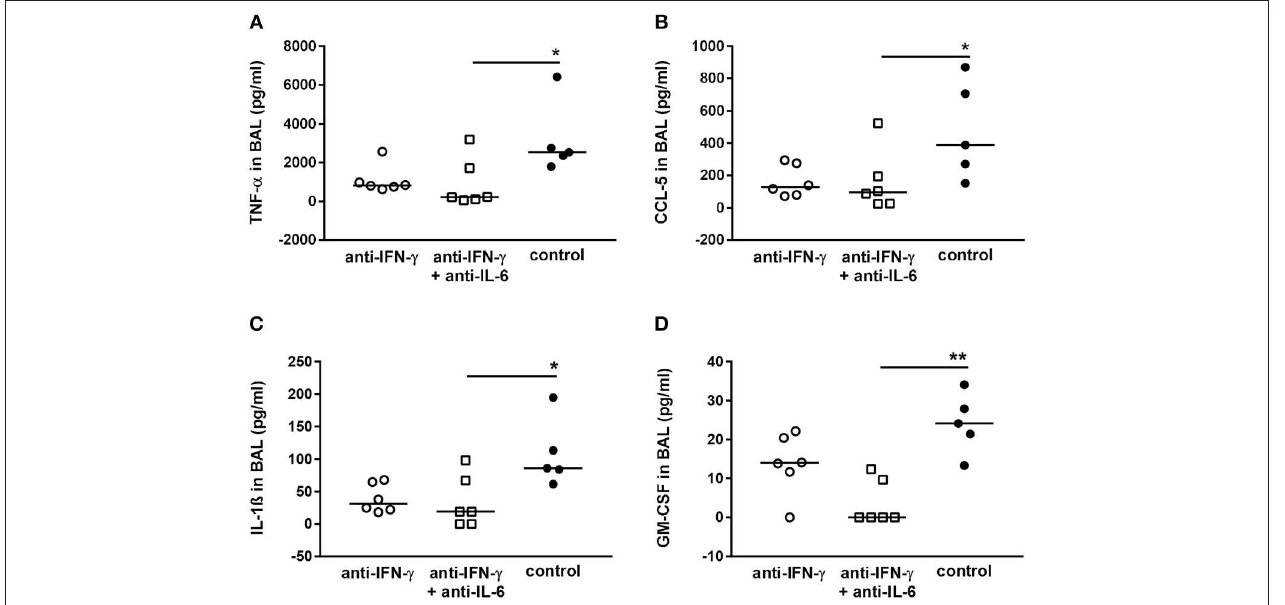
FIGURE 7 | Double-neutralization of IFN- γ and IL-6 during co-infection with 0.17 TCID 50 IAV and 1 × 10 6 CFU S. pn. significantly affects TNF- α , CCL-5, Il-1ß, and GM-CSF protein levels in BAL. Mice were infected intranasally (i.n.) with 0.17 TCID 50 IAV on day 0. On day 5, mice were intraperitoneally (i.p.) injected with anti-IFN- γ antibody alone or in combination with anti-Il-6 antibody. On day 7, mice were treated with anti-IFN- γ antibody alone or in combination with anti-IL-6 antibody oropharyngeally (o.p.) and at the same time infected with 1 × 10 6 CFU S. pn. o.p. The control group was treated with an isotype IgG antibody and infected likewise. (A–D) Protein levels of TNF- α , CCL-5, Il-1ß, and GM-CSF in bronchoalveolar lavage (BAL) 24h post o.p. antibody treatment and S. pn. infection. Data are shown for individual animals indicating the median/group and are compiled from two independent experiments. Neutralizing antibody-treated groups were compared to the control antibody-treated group using the unpaired Kruskal-Wallis test with Dunn’s test for multiple comparisons (* p < 0.05, ** p <